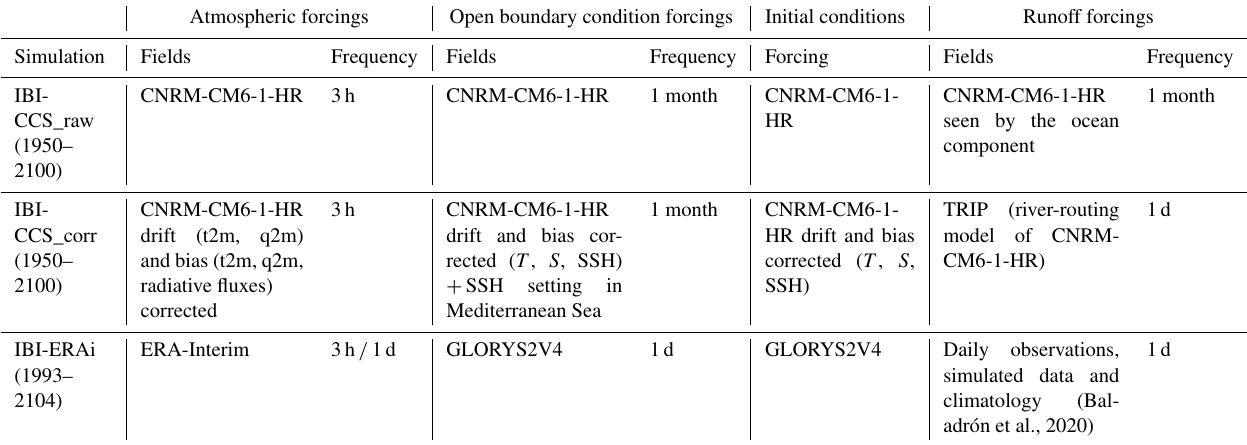
Table 1. Regional IBI-CCS and IBI-ERAi simulation forcings and settings and their corrections when